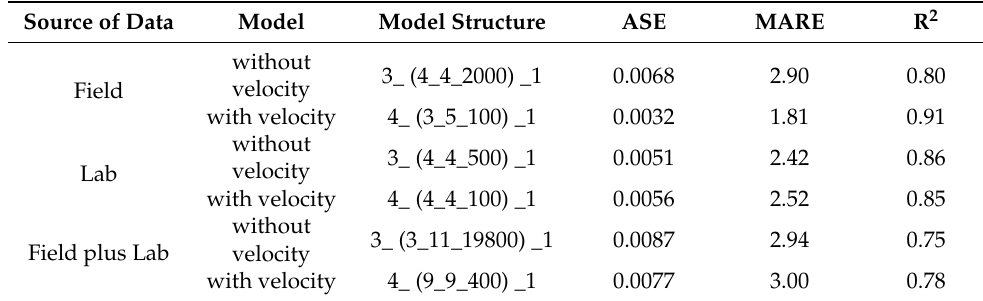
Table 6. Comparing ANN models (predicting dry